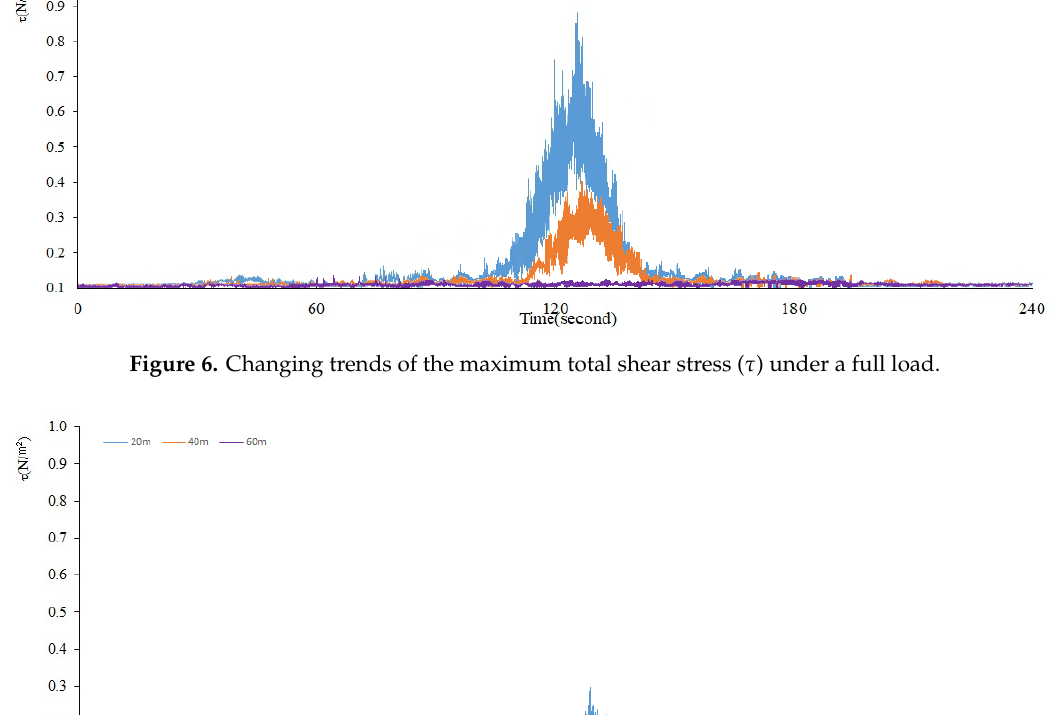
Figure 7. Changing trends of the maximum total shear stress ( τ ) under no load.